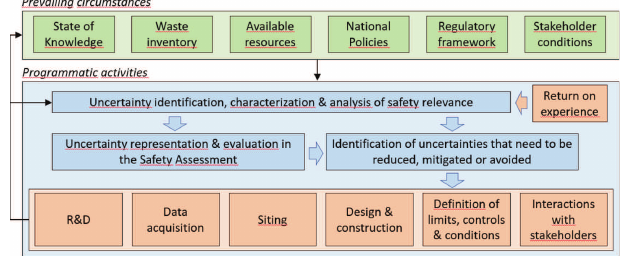
Fig. 5. Key elements of an uncertainty management strategy, and its associated stepwise and iterative